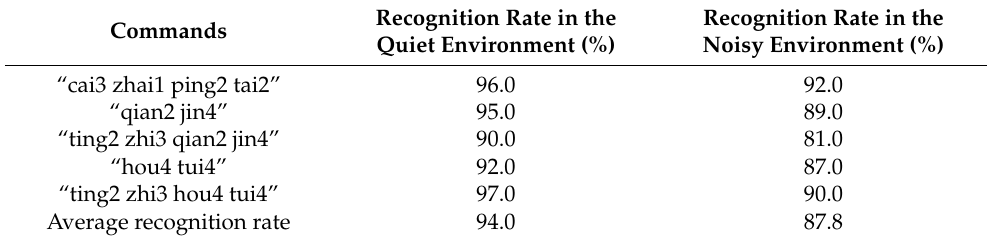
Table 8. Recognition accuracy of the walking voice system in the two environments. Commands